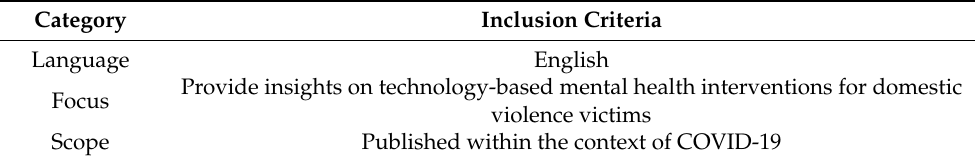
Table 2. Selection